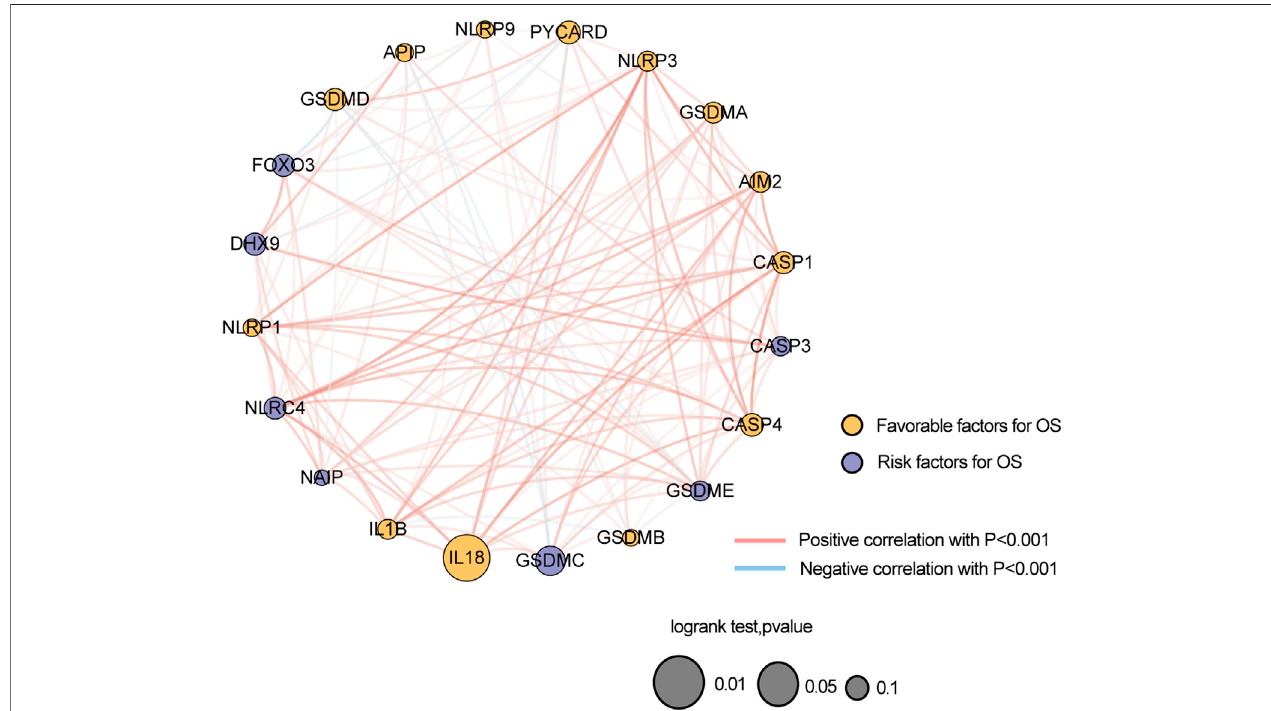
FIGURE 2 | Correlation network of the expression of 20 pyroptosis-related genes in TCGA-BRCA dataset.